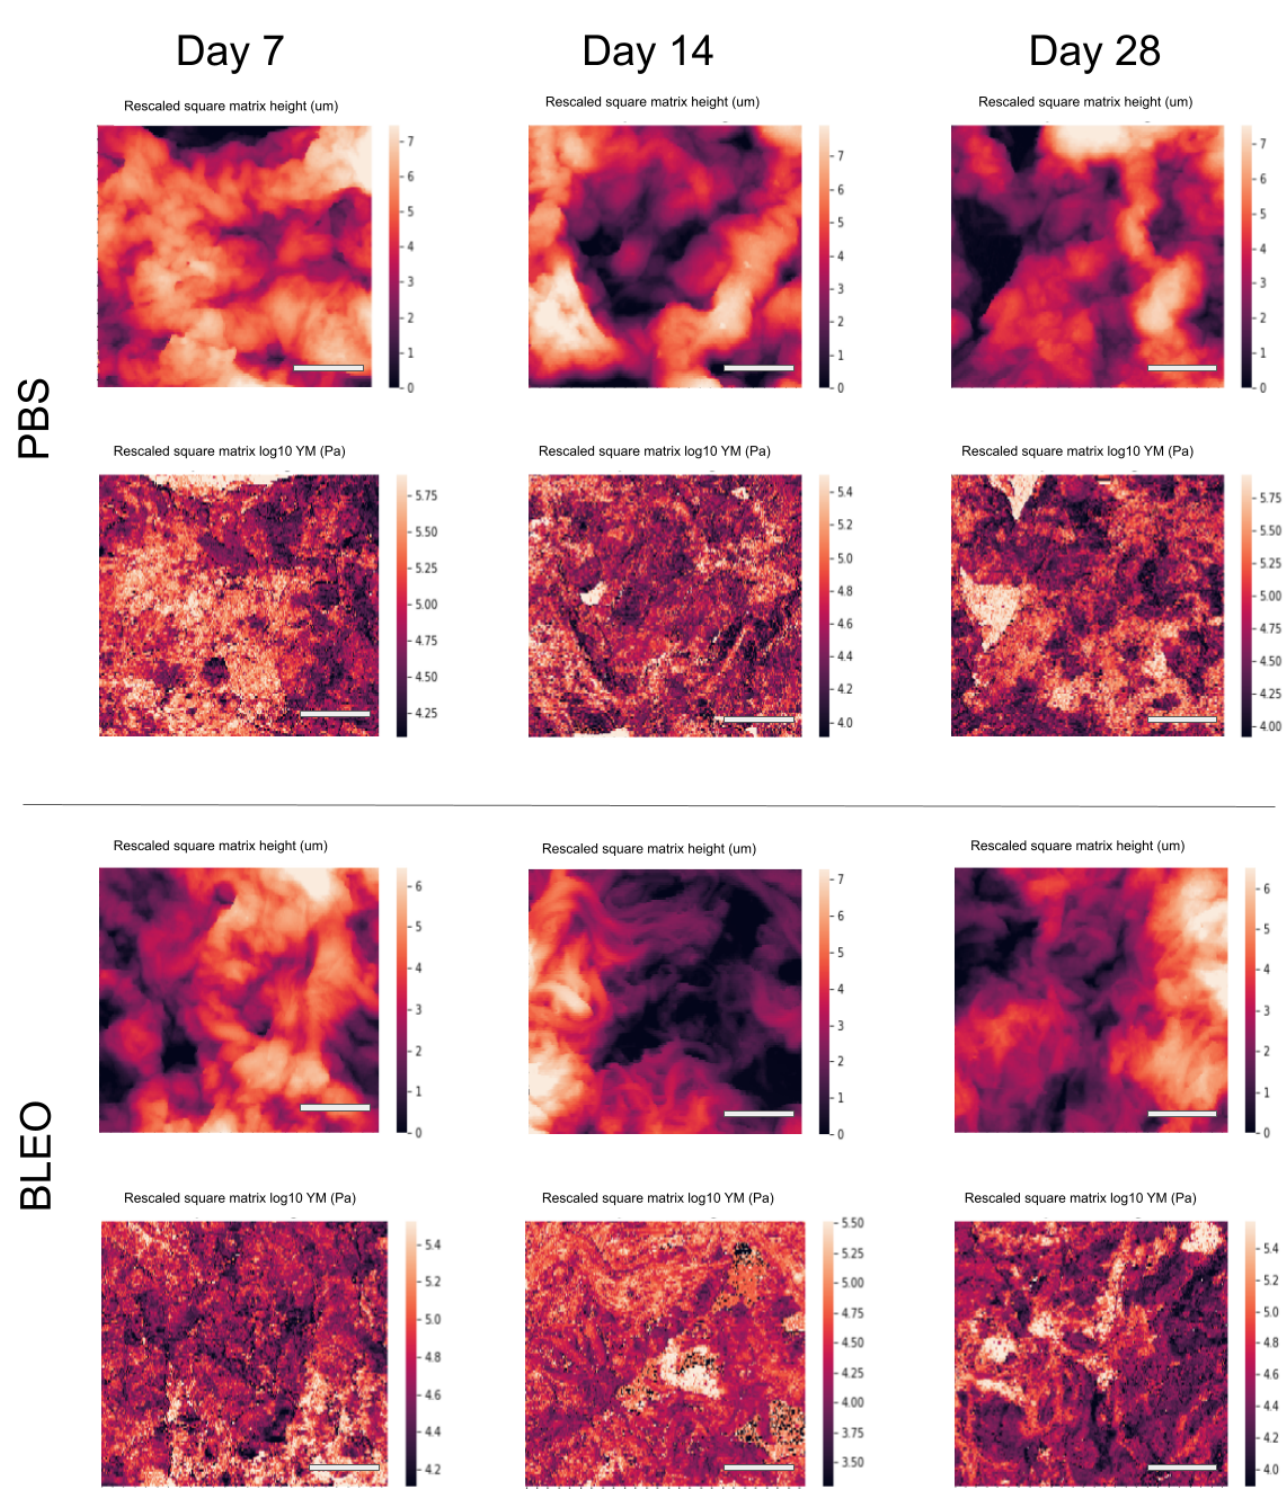
Figure 6. QI images of decellularized ECM from PBS-instilled ( top panel ) and bleomycin-instilled lungs ( bottom panel ). Top rows of each panel correspond to the height profile and bottom rows correspond to elasticity profile. Scale bar = 10 µ